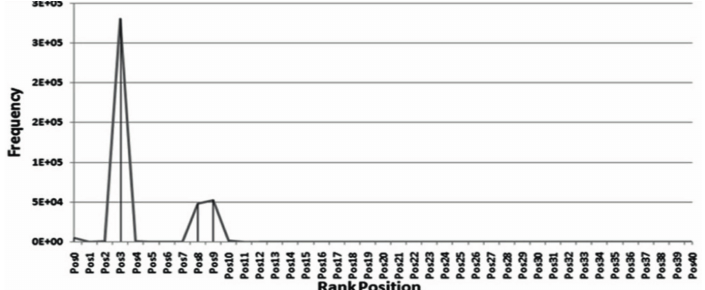
Figure 1. Rank frequency for P 2 (service) for class